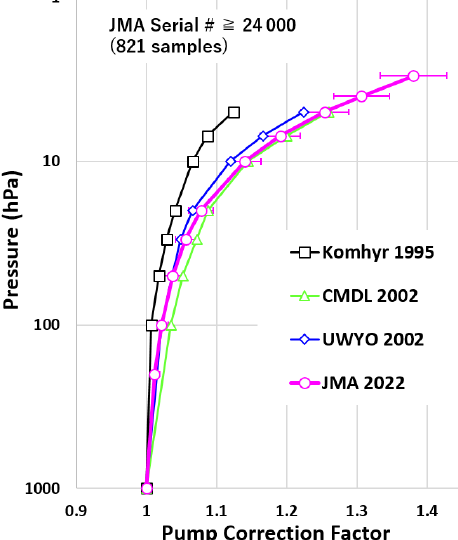
Figure 12. Comparison of pump correction factors from the JMA’s airbag method with those from other experiments. Factors as a func- tion of pressure are represented for the Komhyr et al. (1995) stan- dard by the black line with squares, and JMA factors are repre- sented by the pink line with circles. The error bars represent 1SD. NOAA/CMDL average oil bubble flowmeter values are shown by the green line with triangles, and those from the University of Wyoming bag method are shown by the blue line with rhombuses (Johnson et al., 2002).